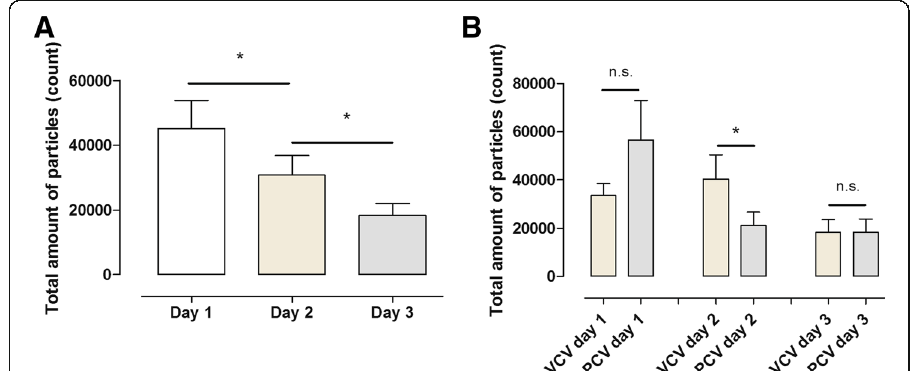
Fig. 1 The figure shows the total accumulated particle count measured by a customised PExA instrument during volume-controlled ventilation (VCV) and pressure-controlled ventilation (PCV) during three consecutive days ( n = 5) ( a ). In b , VCV and PCV are divided into separate groups. Note the significant increase in total particle count on day